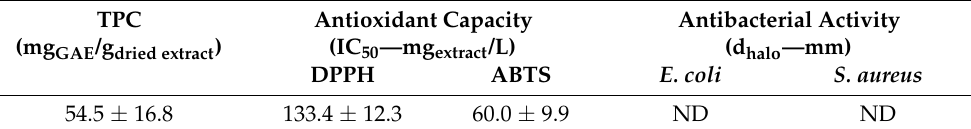
Table 2. Results from the bioactive characterization of M. oleifera extract. TPC (mg GAE /g dried extract